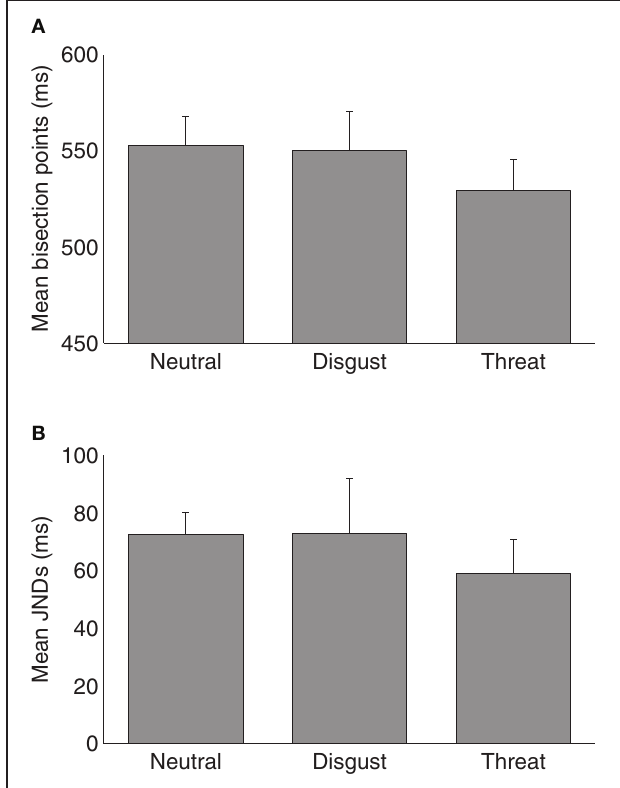
FIGURE 2 | (A) Mean temporal bisection points and (B) mean JNDs (and associated standard errors) for three emotional conditions ( n =